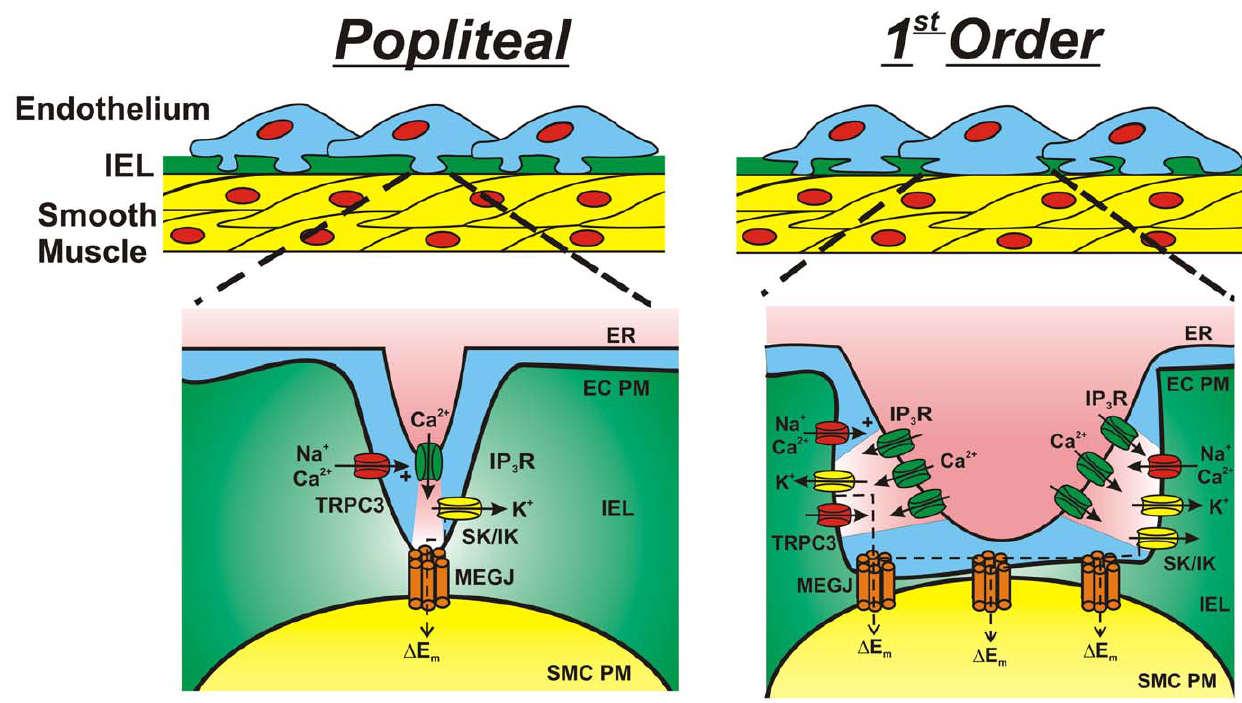
Figure 9. ‘‘Working hypothesis’’ schematic for electrical communication within large and small skeletal muscle arteries. Proposed vascular signaling among skeletal muscle popliteal (left) and 1 st order (right) arteries. ER, endoplasmic reticulum; EC PM, endothelial cell plasma membrane; IEL, internal elastic lamina; SMC PM, smooth muscle cell plasma membrane; IP3R, inositol trisphosphate receptor; SK, small conductance calcium-activated potassium channel (KCa2.3); IK, intermediate conductance calcium-activated potassium channel (KCa3.1); TRPC3, canonical transient receptor potential channel 3; MEGJ, myoendothelial gap junction.